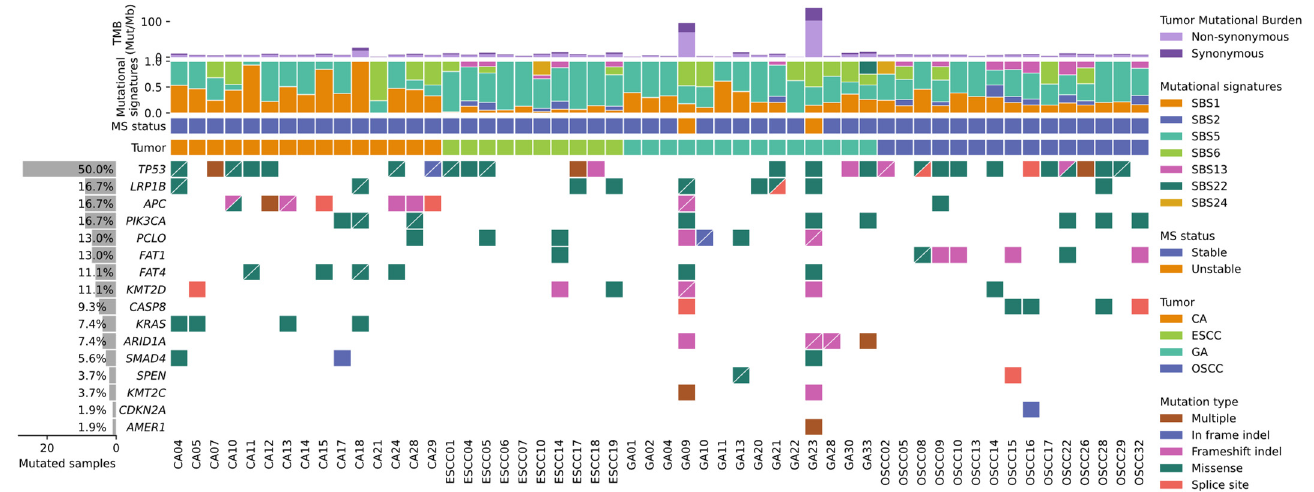
Figure 4. Whole-exome sequence of 54 OGITC with tumor mutational burden (TMB) and MSI sta- tus.